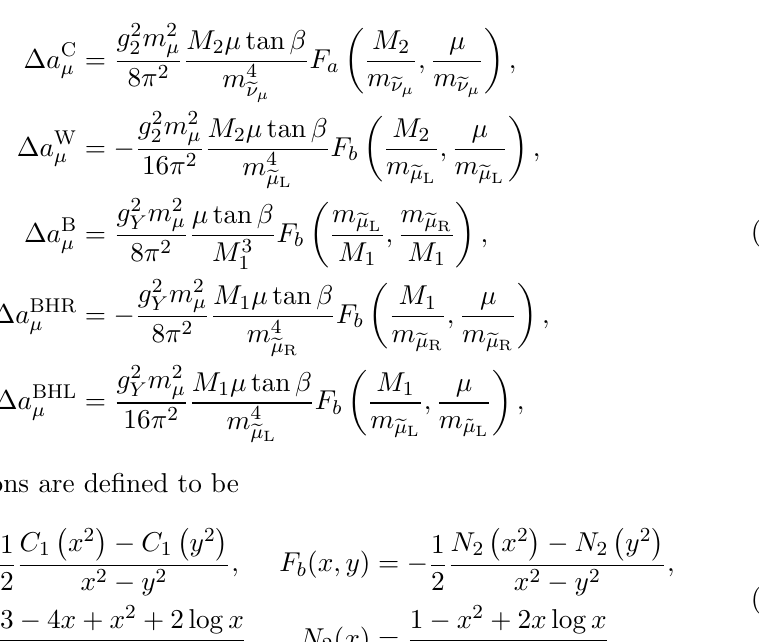
Figure 2 . Branching ratios of the allowed s decay modes as function of scalar mass m s , with typical values of SUSY parameters ( M 1 = 100 GeV, M 2 = 1 TeV, red curve shows branching ratios BR( s ! e + e (cid:0) ), and the green curve represents the BR( s ! (cid:13)(cid:13) ). wino-slepton loop (W), bino-slepton loop (B), bino-higgsino loop (BHR and BHL) [68,